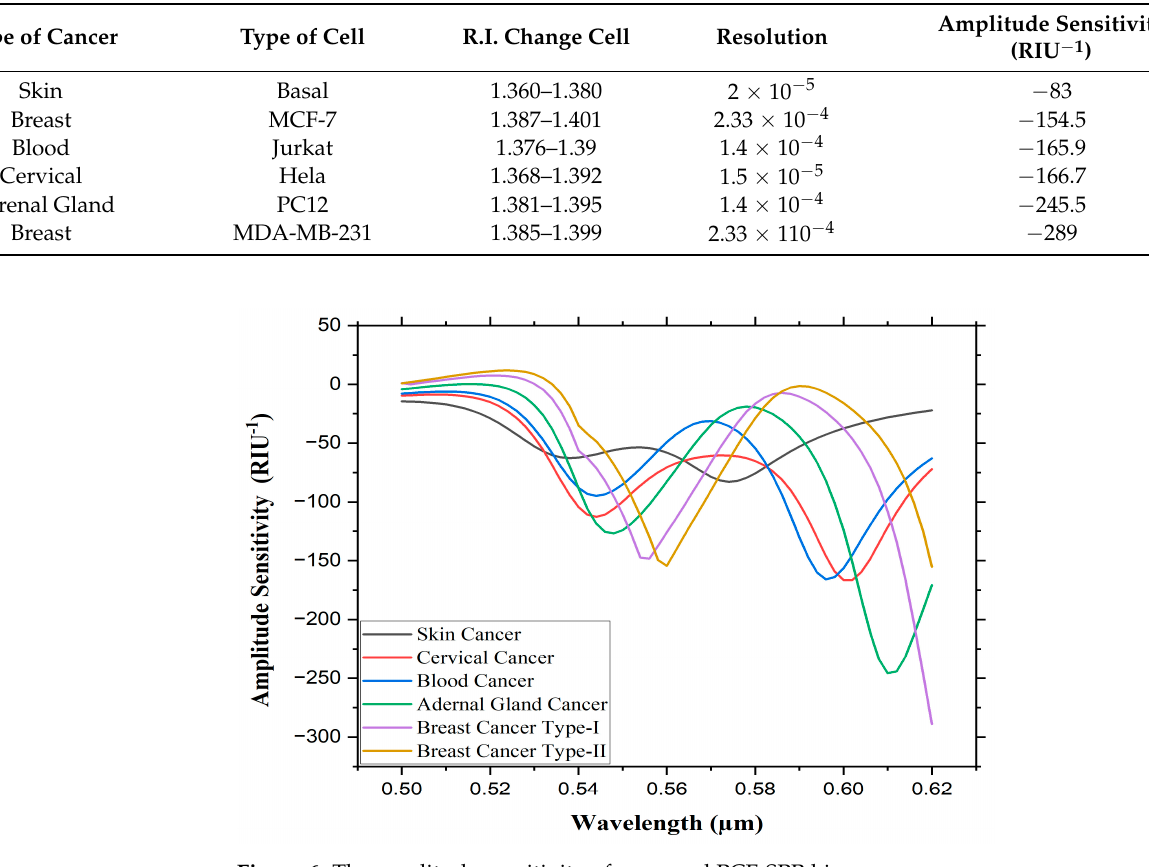
Figure 6. The amplitude sensitivity of proposed PCF-SPR biosensor.